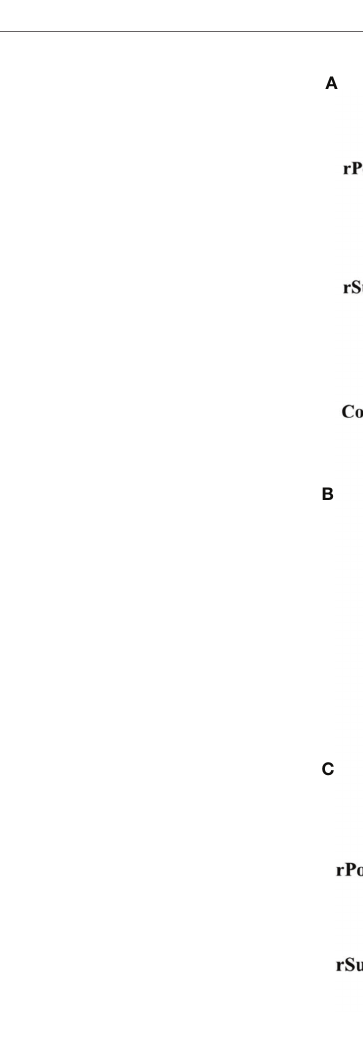
FIGURE 8 | Binding of rPoC3a to peripheral blood leukocytes (PBL). (A) PBL was incubated with or without (control) rPoC3a or rSumo, and FITC-labeled goat anti- mouse IgG was used to detect the proteins bound to the cells. The cells were stained with DAPI and observed with a confocal microscope. Bar, 10 m m. (B, C) Chemotactic activity of rPoC3a. The chemotactic activity of rPoC3a in various concentrations against PBL was determined using transwell migration assay. Chemotactic index was presented as fold increase in the number of migrated cells induced by rPoC3a compared to that induced by PBS (control). Data are shown as means ± SEM (N = 3). N, the number of times the experiment was performed. **P < 0.01; *P < 0.05. (C) The migrated cells induced by the rPoC3a in (B) were observed under a microscope. Bar, 20 m